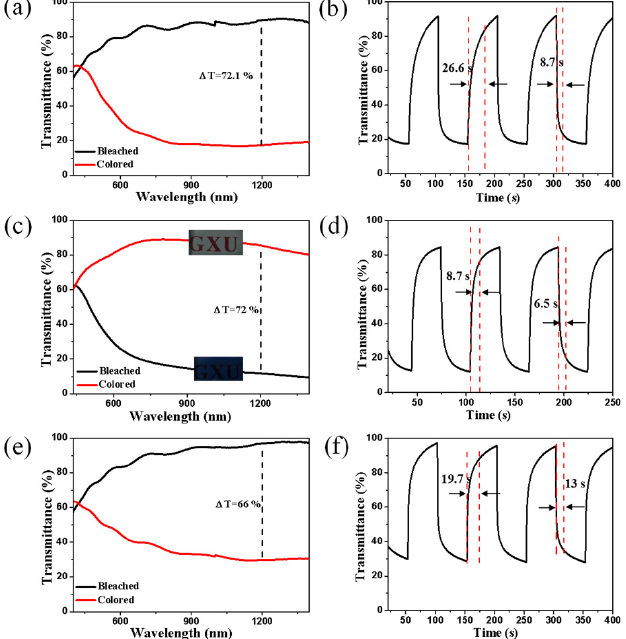
Figure 4. ( a , c , e ) Optical transmittance spectra, ( b , d , f ) switched response curves of the WO 3 nanoblocks, nanosheets, and nanoribbons array films.